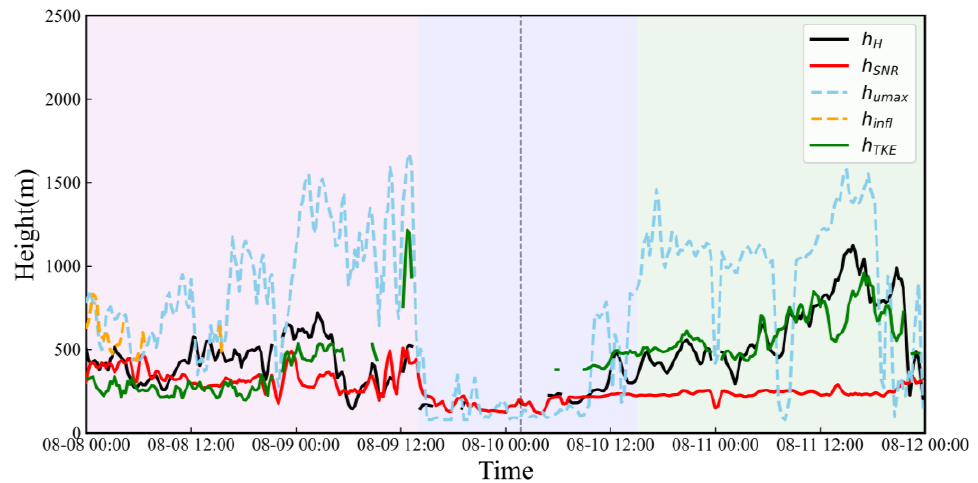
Figure 9. Variation of BLH with time calculated for S_1 using five methods. Table 4. Mean values of BLHs when S_1 is in different quadrants of the typhoon center.